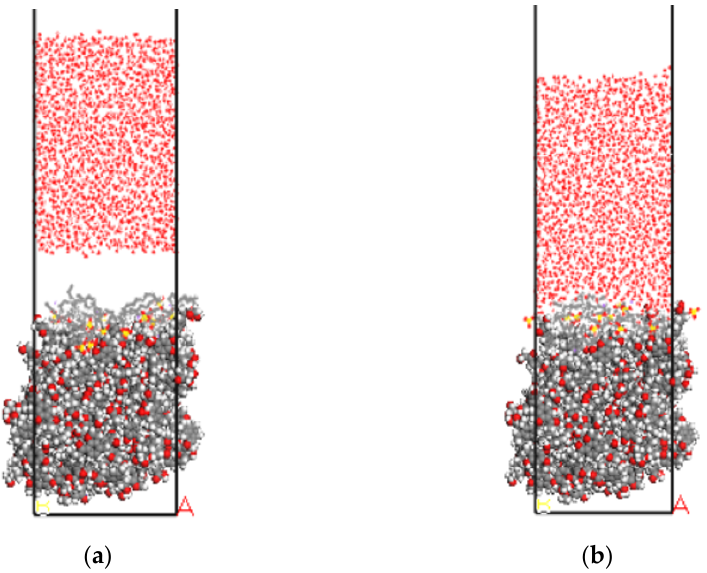
Figure 8. The initial ( a ) and equilibrium ( b ) configurations of the water-SDS-lignite system.